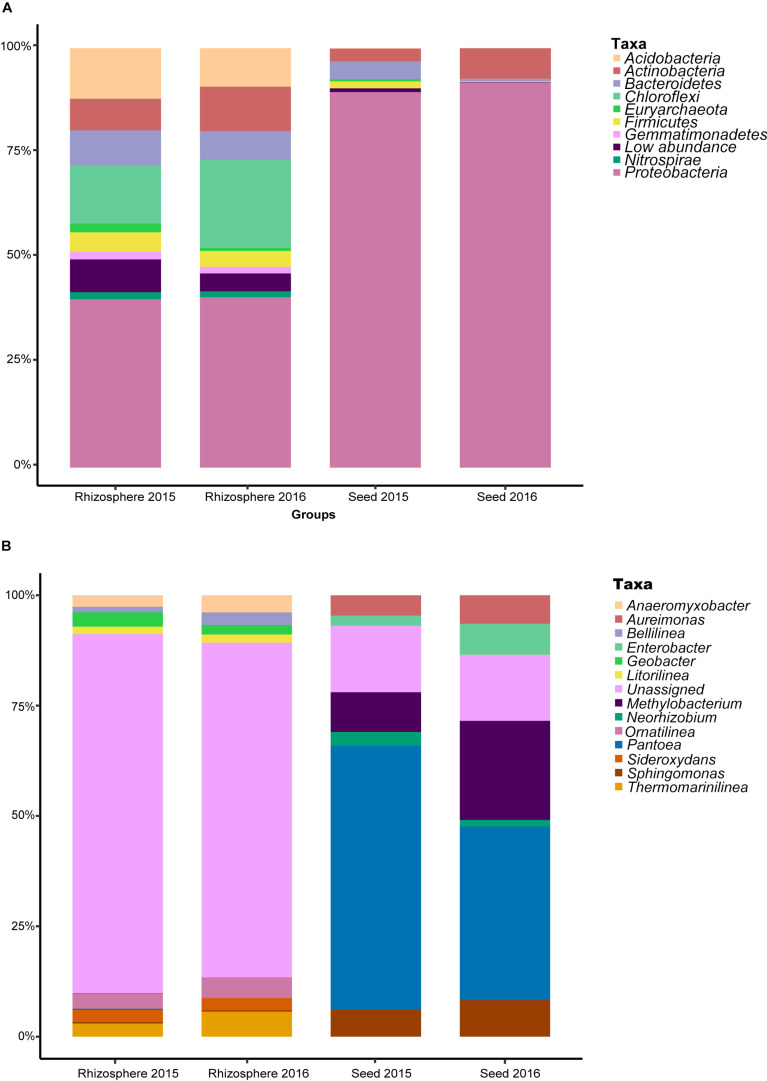
The relative abundance of the most predominant bacterial taxa at the (A) phylum, and (B) genus levels.